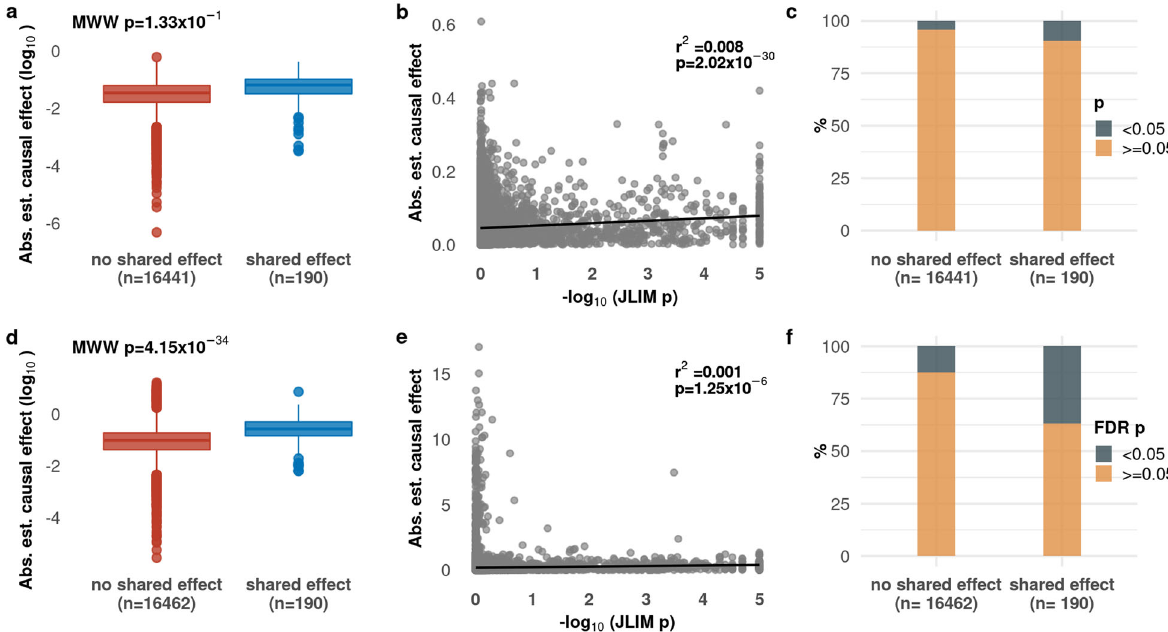
Fig. 4 Trait pairs sharing an association are more likely to be causally related. We assessed evidence for causality between gene expression and immune cell traits using Mendelian randomization with cis-eQTL (expression quantitative trait loci) single nucleotide polymorphisms (SNPs) ( a – c ) and an expanded set of instruments including nearby genes ( c – e ). For the latter, we saw a signi fi cant level of increased evidence for causal effects in trait pairs with a shared effect (blue) compared to pairs without a shared effect (red) ( d ). We also saw an overall correlation between evidence for shared effects and the estimated causal effect size ( b , e ). The percentage of trait pairs with a p -value of <0.05 in the TSMR was higher for trait pairs sharing an association ( c ) as was the percentage of trait pairs with an FDR adjusted p -value of <0.05 when using an expanded set of instruments ( f ). MWW = Mann – Whitney – Wilcoxon